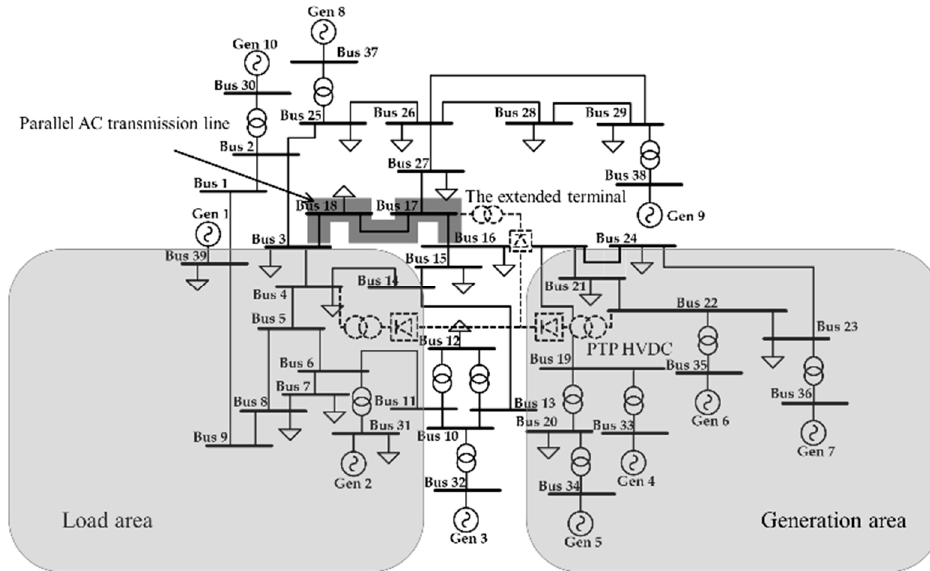
Figure 12. Modified IEEE 39 bus test system and the applied DC system.